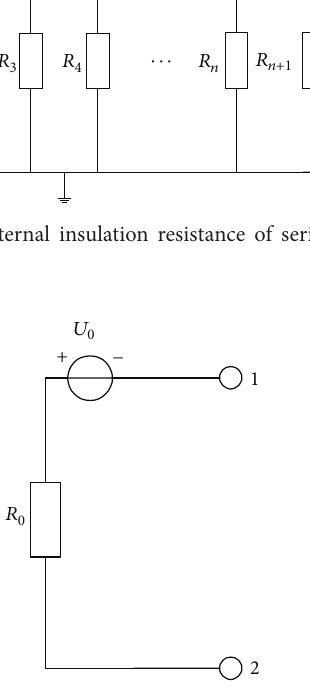
Figure 12: Simplified insulation